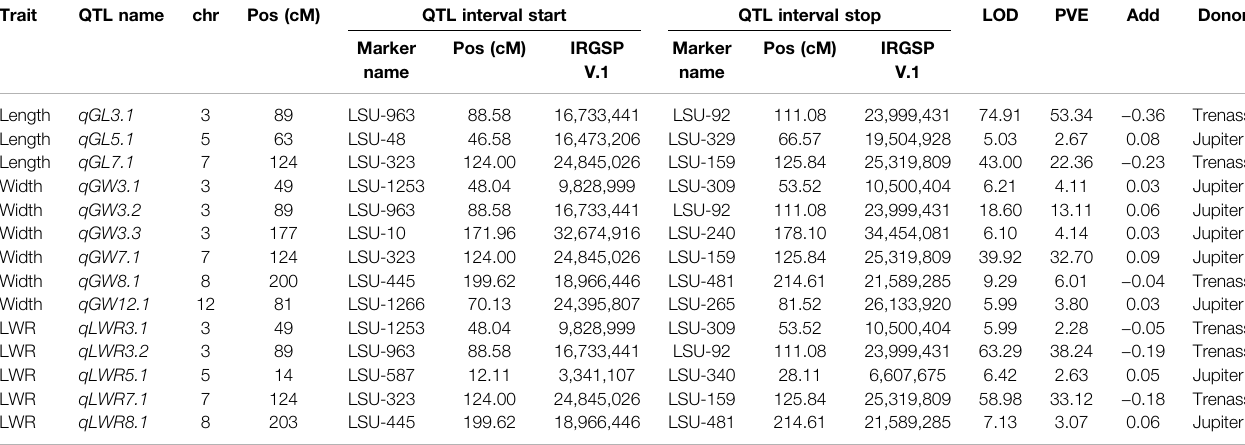
TABLE 1 | Grain dimension Quantitative trait loci (QTL) detected in the Trenasse/Jupiter Recombinant Inbred Line population.